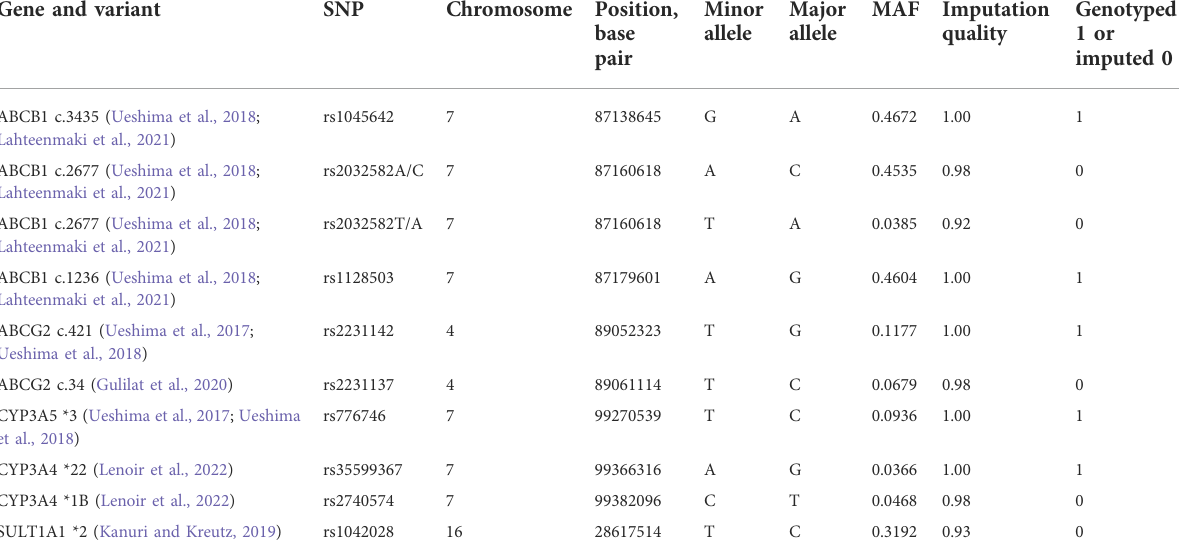
TABLE 2 List of candidate single nucleotide polymorphisms. Gene and